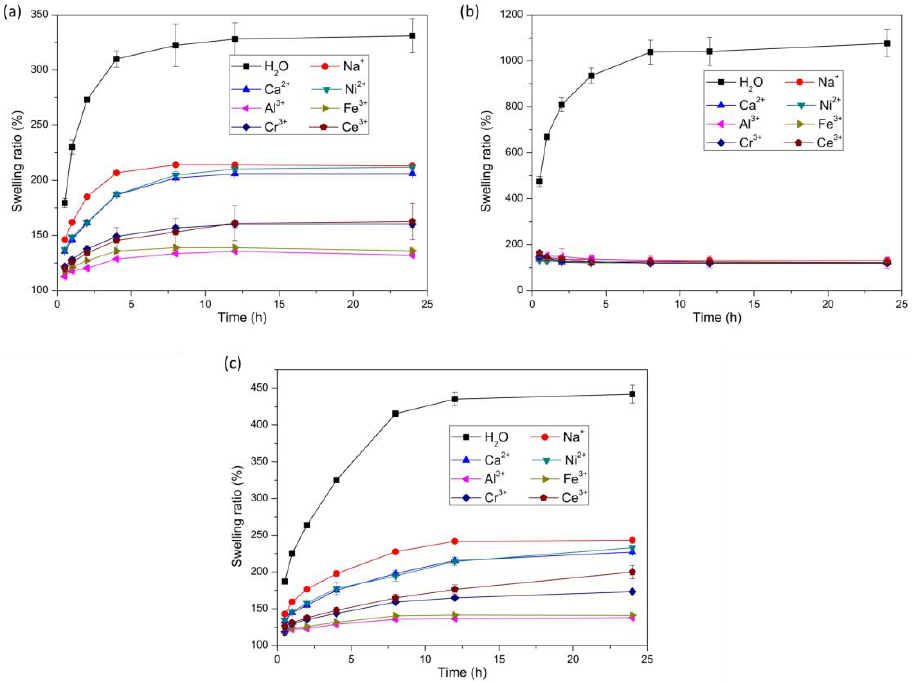
Figure 2. Swelling behavior of AAc/AAm hydrogels ( a ), NIPAM hydrogels ( b ), and bilayer hydrogels ( c ) soaked in deionized water, 0.6 mol/L NaCl solution, 0.6 mol/L CaCl 2 solution, 0.6 mol/L NiCl 2 solution, 0.6 mol/L AlCl 3 solution, 0.6 mol/L FeCl 3 solution, 0.6 mol/L CrCl 3 solution, and 0.6 mol/L CeCl 3 solution. (n = 3).